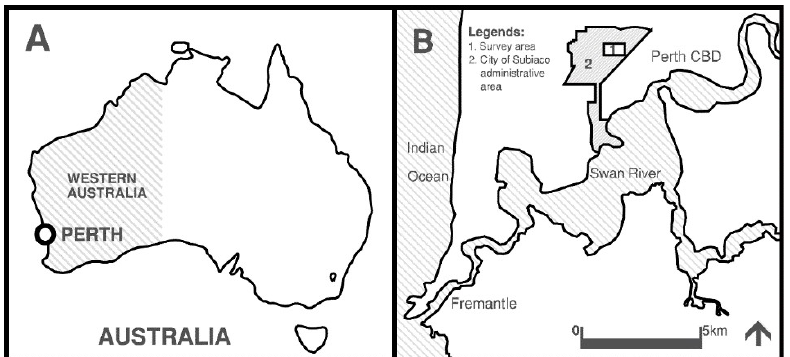
Figure 2. Maps of Australia and Perth: ( A ) Australia ( B ) Subiaco.